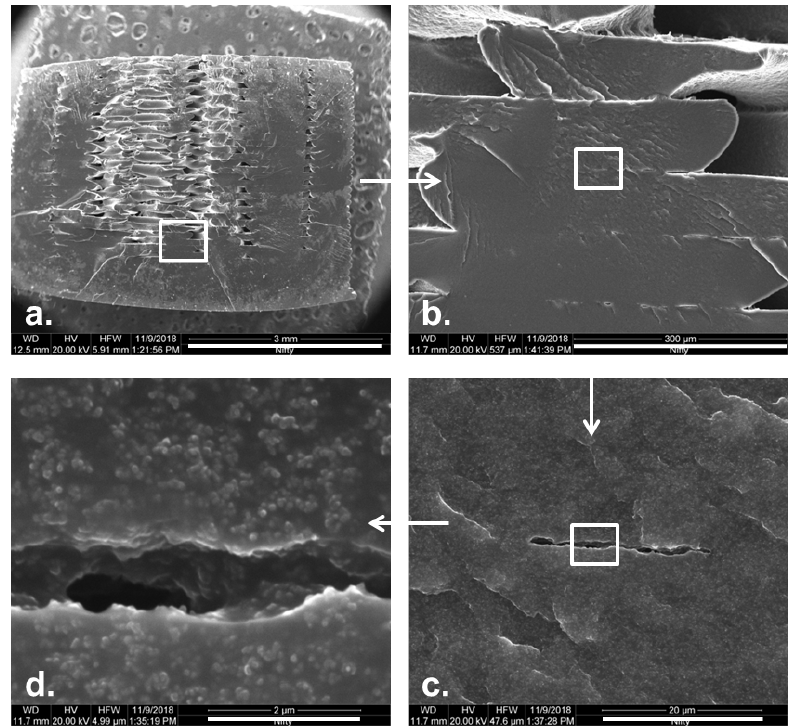
Figure 2. The SEM images of a cross section of a 3D-printed sample with cross-ply infill, prepared with cryo-fracturing: ( a ). the full cross section (scale bar 3mm), ( b ). several traxels (scale bar 300µm), ( c ). void between traxels (scale bar 20µm), and ( d ). void close-up showing carbon black particles in the void (scale bar